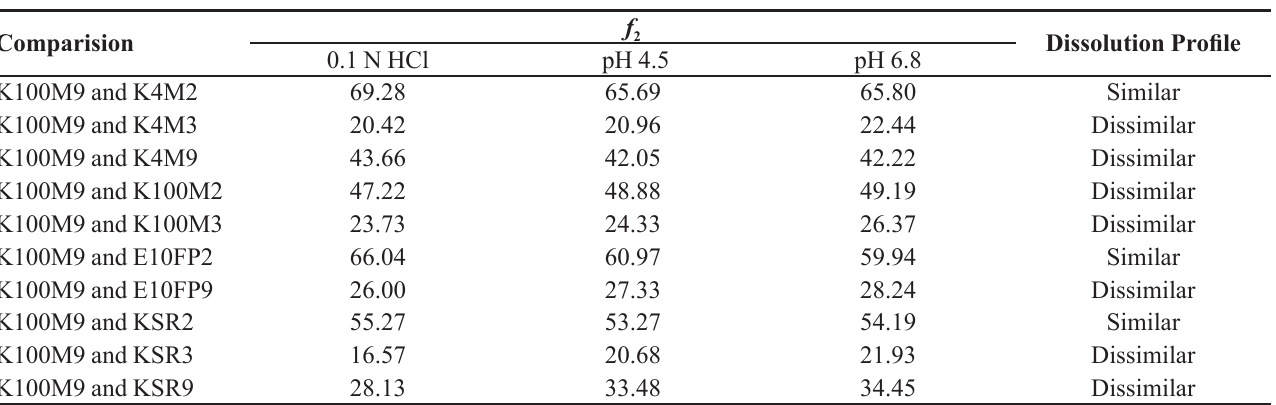
) Values of Tizanidine formulations 2